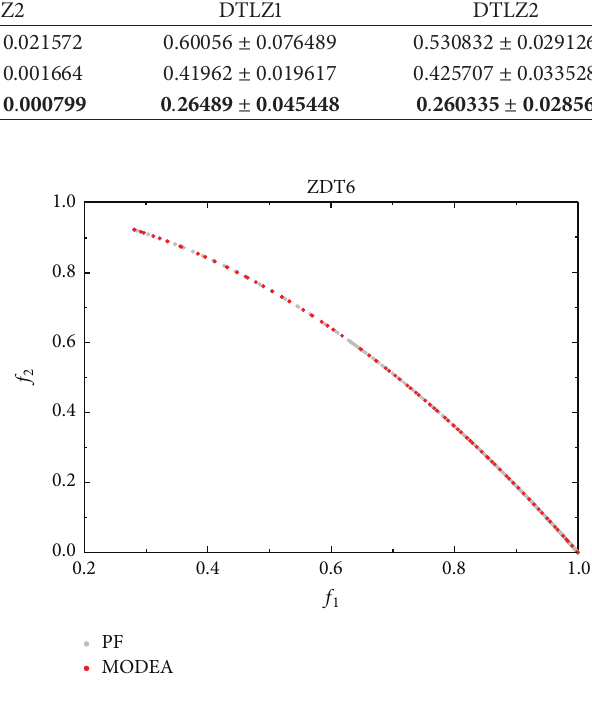
Figure 6: Plots of the nondominated solutions with the lowest IGD- metric values found by MODEA in 10 runs in the objective space on ZDT6 where 𝑁 = 100 and 𝑇 = 250